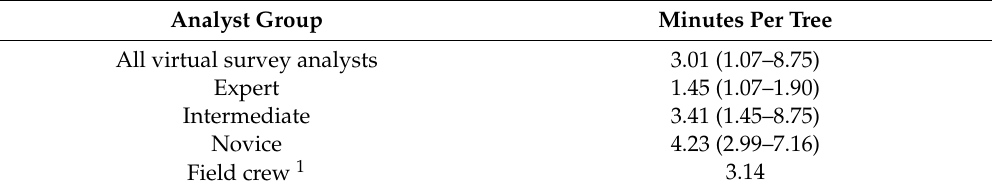
Table 2. Comparison of time spent per tree during data collection. Group ranges are in parentheses for virtual survey